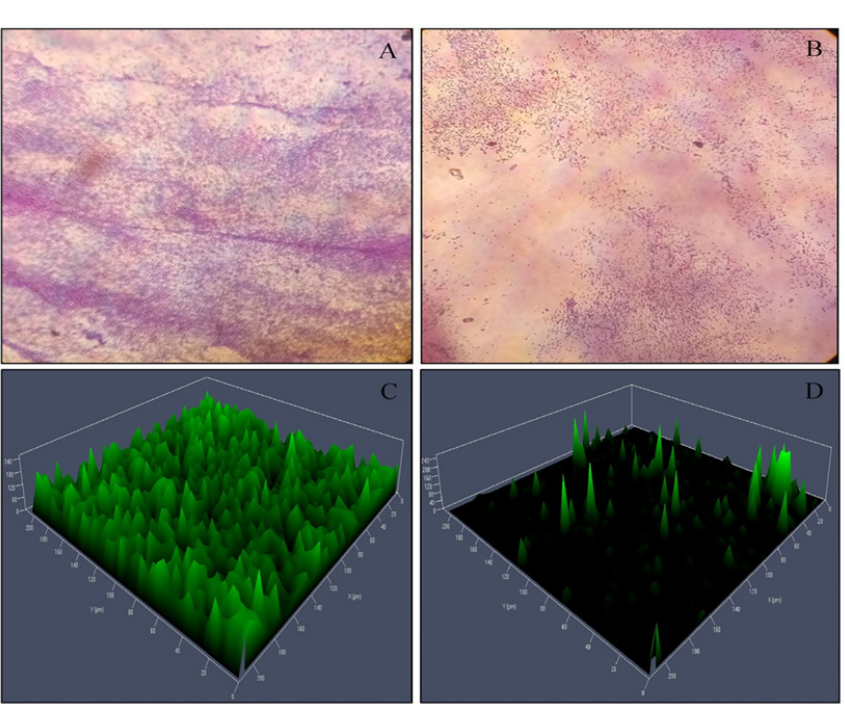
Fig. 3. Microscopic (Light microscopy and CLSM analysis) observation of P. aeruginosa PAO1 biofilm. (A) Light microscopic observation of untreated P. aeruginosa PAO1 biofilm, (B) Light microscopic observation of P. tenuiflorus treated P. aeruginosa PAO1 biofilm, (C) CLSM analysis of untreated P. aeruginosa PAO1 biofilm, (D) CLSM analysis of P. tenuiflorus treated P. aeruginosa PAO1 Table 1. Effect of sub-MIC dose (500 µg/ml) of P. tenuiflorus extract on production of QS regulated biofilm phenotypes in P. aeruginosa PAO1 S. No.